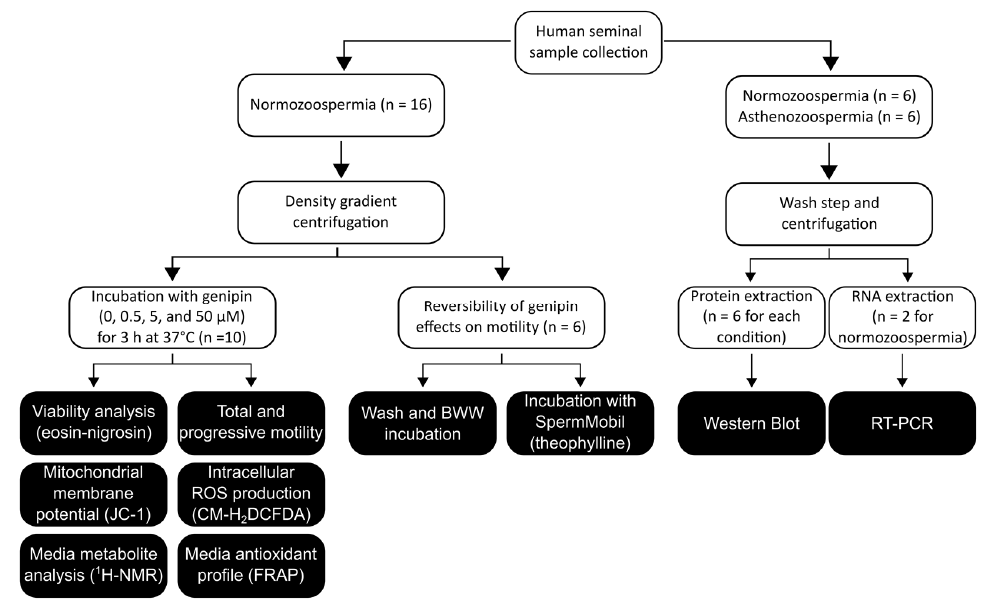
Figure 1. Schematic workflow of the experimental design applied in this study.